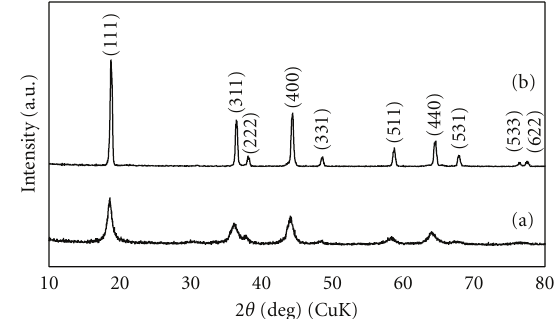
Figure 4: XRD patterns of LiNi 0 . 5 Mn 1 . 5 O 4 powders, (a) as- prepared, (b) calcined at 800 ◦